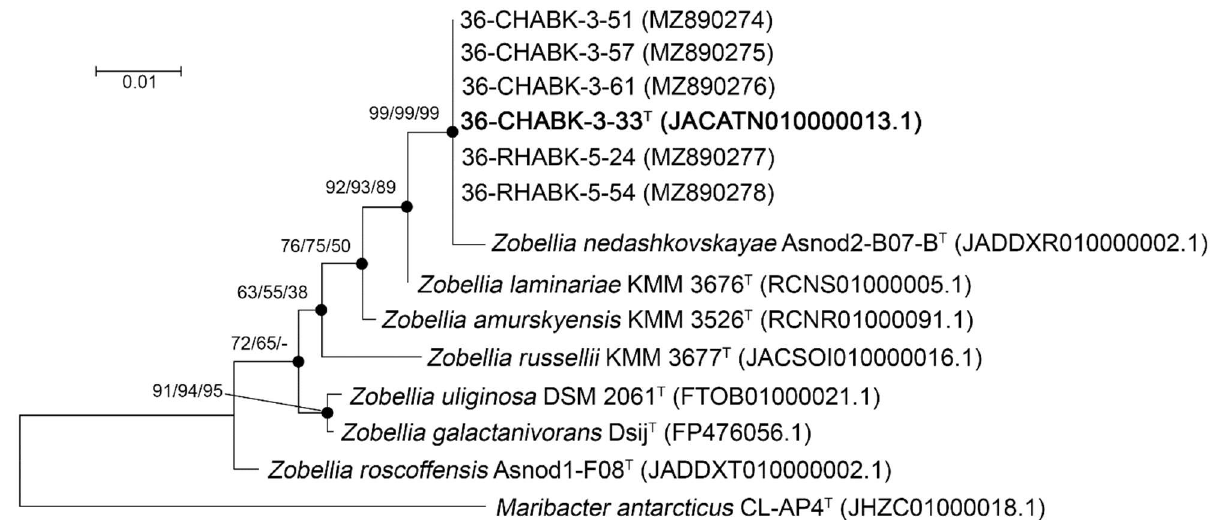
Figure 1. Maximum-likelihood (ML) phylogenetic tree based on 16S rRNA gene sequences, showing the phylogenetic position of six alga-associated isolates and other members of the genus Zobellia . The ML tree was inferred using the K2+G model recommended by MEGA v.7. Bootstrap values in the order ML/NJ/MP are based on 500/1000/500 replications. Bar, 0.01 substitutions per nucleotide position.